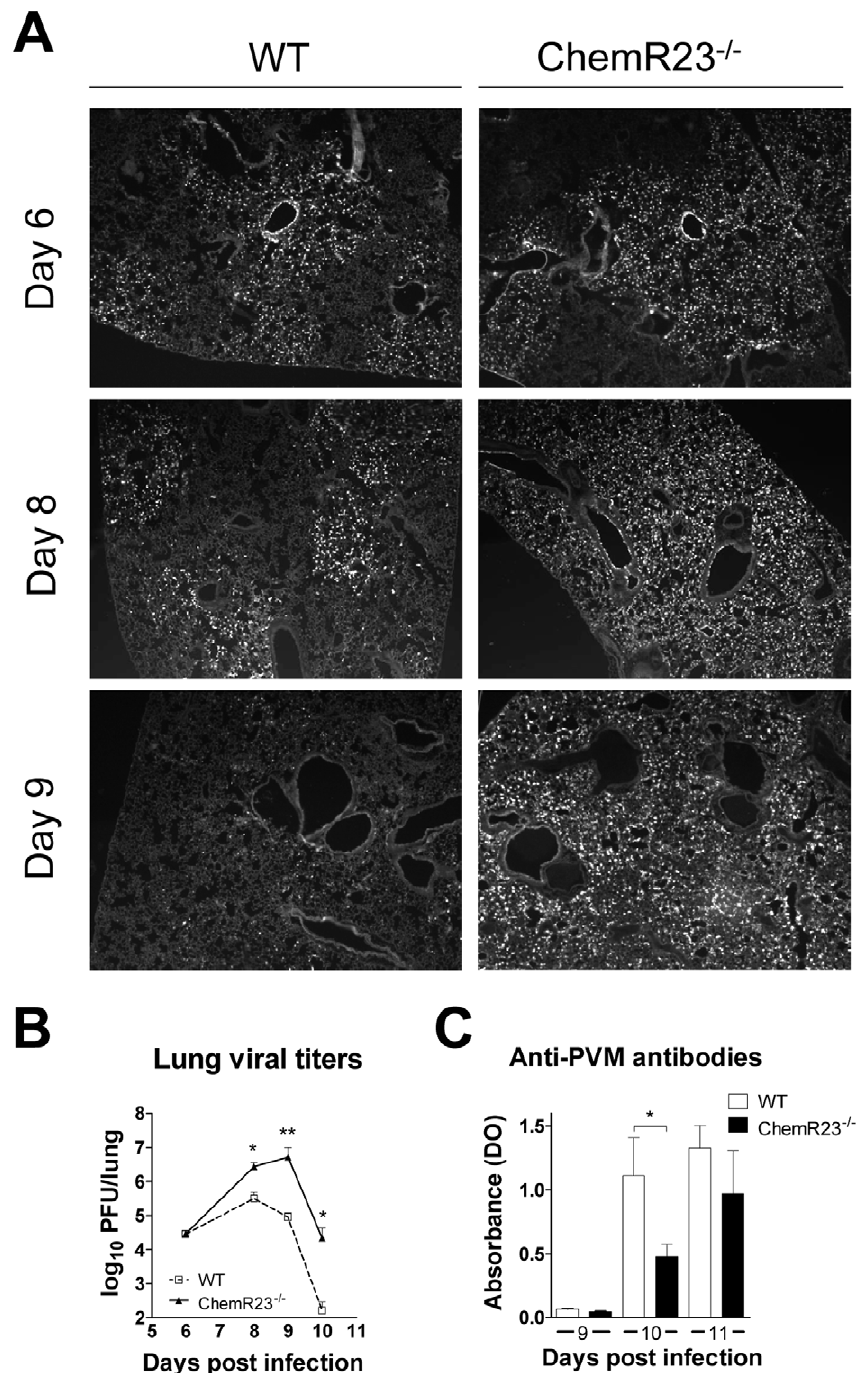
Figure 3. Increased viral load and delayed viral clearance in ChemR23 2 / 2 mice. ( A ) Immunofluorescent staining of viral antigens in lung sections at 6, 8, and 9 days post-infection of wild-type (WT) and ChemR23 2 / 2 mice. Original magnification: 6 50. ( B ) Viral titers were determined in lung homogenates for WT (open squares) and ChemR23 2 / 2 (filled triangles) mice at selected time points post-infection, and expressed in log 10 plaque-forming units (PFU) per lung. ( C ) At days 9, 10, and 11 post-infection, the serum of infected mice was assessed for the presence of anti-PVM antibodies by ELISA. The displayed data are the mean 6 SEM for groups of seven animals and are representative of at least two independent experiments. *, p , 0.05; **, p , 0.01.